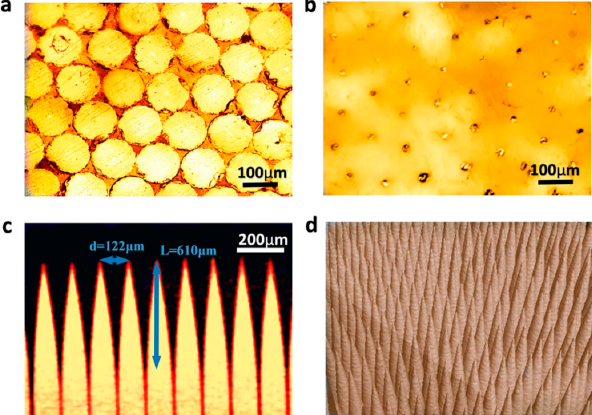
Figure 11. Pyramidal cone metamaterial matching layer showing ( a ) hexagonal close-packed silica columns with maximum acoustic impedance nearing silica, ( b ) top side of the matching layers showing the tips of the silica fibers with the lowest acoustic impedance, ( c ) the cross-section of the metamaterial matching layer, and ( d ) the 3D topography showing the pyramidal cone arrays. Reproduced from [307],